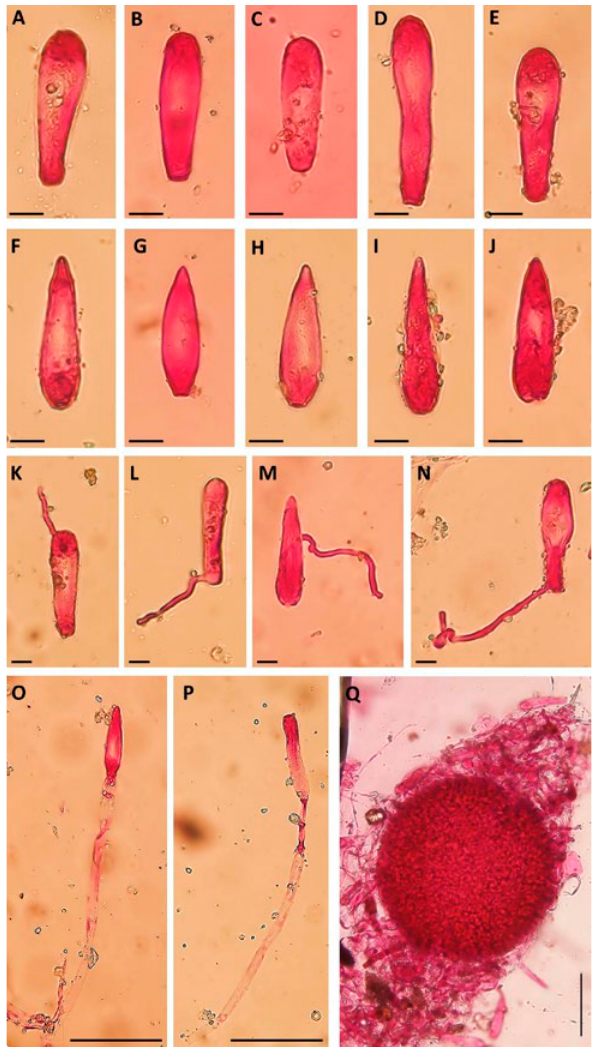
Figure 2. Micrographs of Leveillula lactucae-serriolae . A-E, shape variability of primary conidia; F-J, secondary conidia; K-N, germ development from primary and secondary conidia; O, conidiophore with primary conidia; P, conidiophore with secondary conidia; Q, chasmothecium . Bars = 10 μm in A-N) and 50 μm in